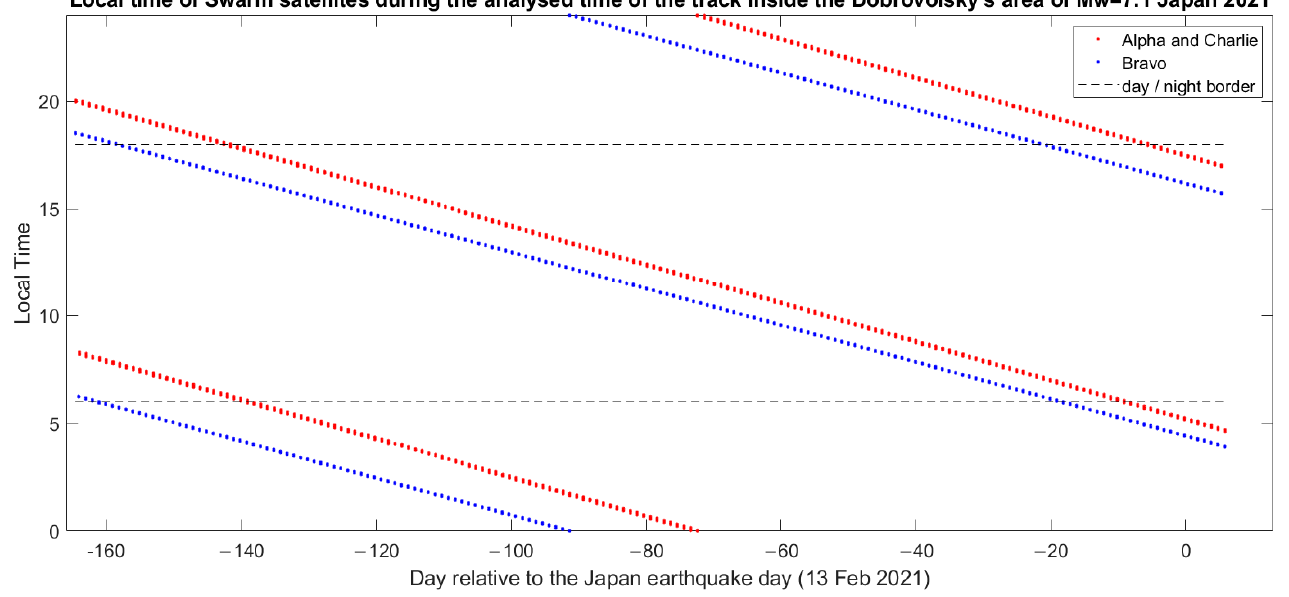
Figure 17. Swarm local time as a function of time during the period investigated in this study. The two “borders” (i.e., the terminators) between night and day at 6 LT and 18 LT are underlined by black dashed lines. Swarm Alpha and Charlie are represented by red dots (their local time is very close to each other) while the local time of Swarm Bravo is shown by blue dots.